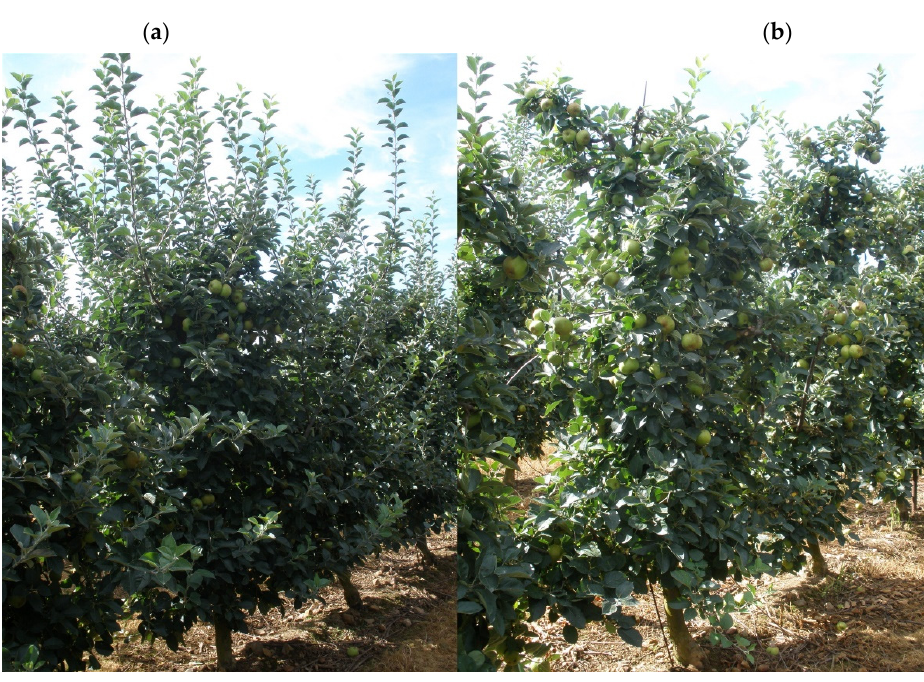
Figure 1. Illustration of summer pruning performed in ‘Reinette du Canada’ apple trees: ( a ) Control trees; ( b ) Pruned trees. trees; ( b ) Pruned